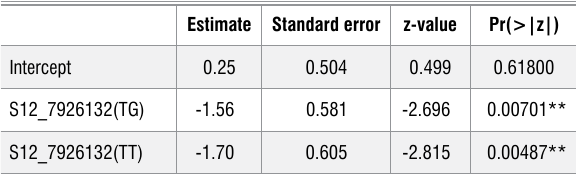
Table 5: A prediction model for CMDSS using binary logistic regression Estimate Standard error z-value